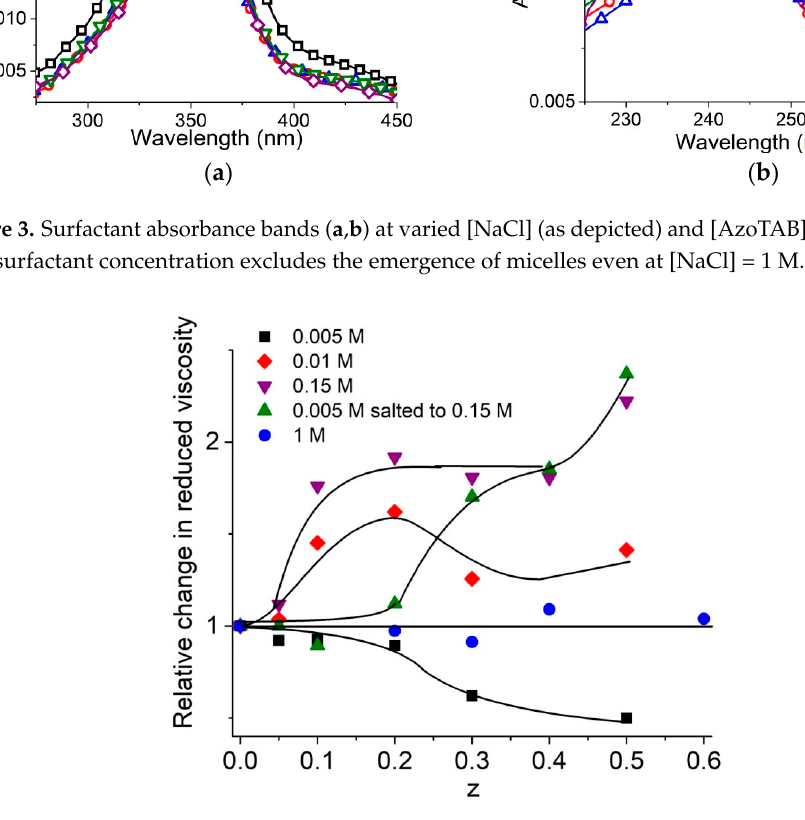
Figure 4. Dependence of relative change in reduced viscosity of DNA solutions on z value at varied [NaCl] (as depicted). [DNA] = 1.5 × 10 − 4 M(P); [DNA] = 2.4 × 10 − 4 M in 1 M NaCl.